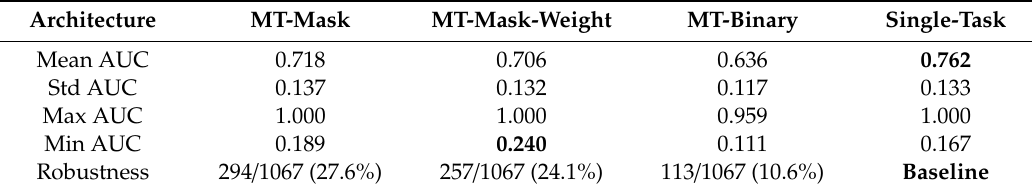
Table 4. Comparison of deep neural architectures for human targets.